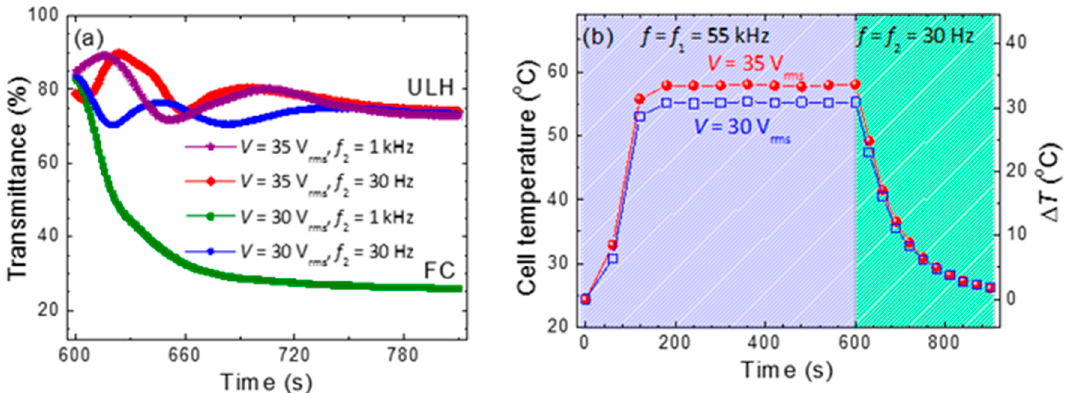
Figure 5. ( a ) Time-dependent transmission curves of the cell after the switching of the frequency of the hybrid pulse from f 1 (= 55 kHz) to f 2 and ( b ) time-dependent temperature and temperature variation of the cell during the application of hybrid pulses at V = 35 V rms and V = 30 Vrms . The duration of the pulse at f 1 is 600